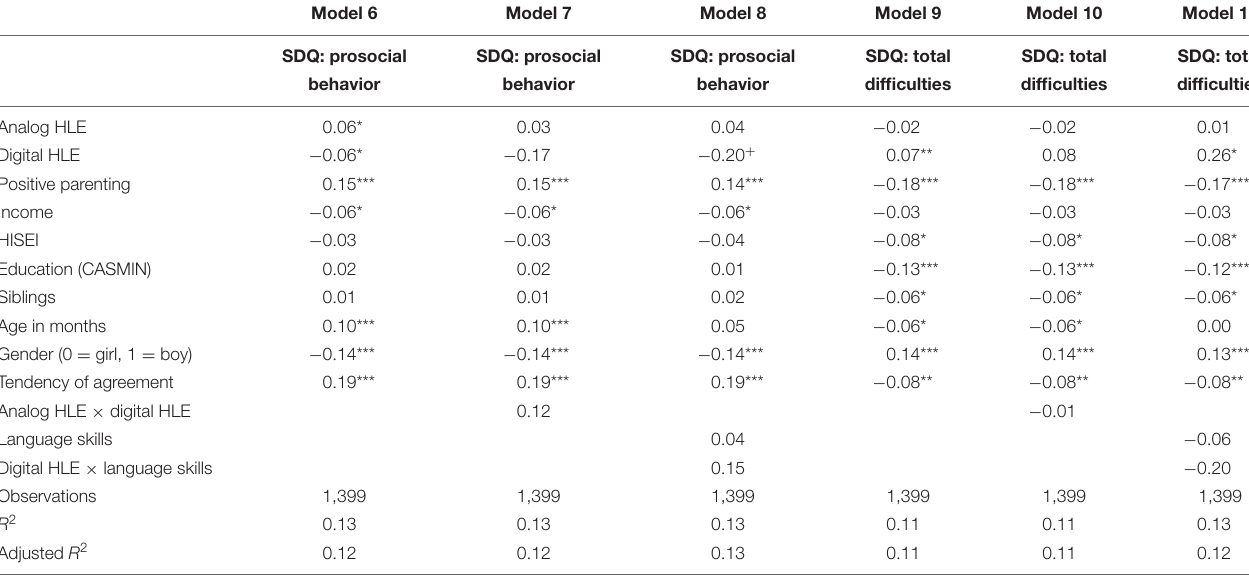
TABLE 7 | Multivariate regressions: associations between preschooler’s socio-emotional outcomes and digital and analog HLEs.